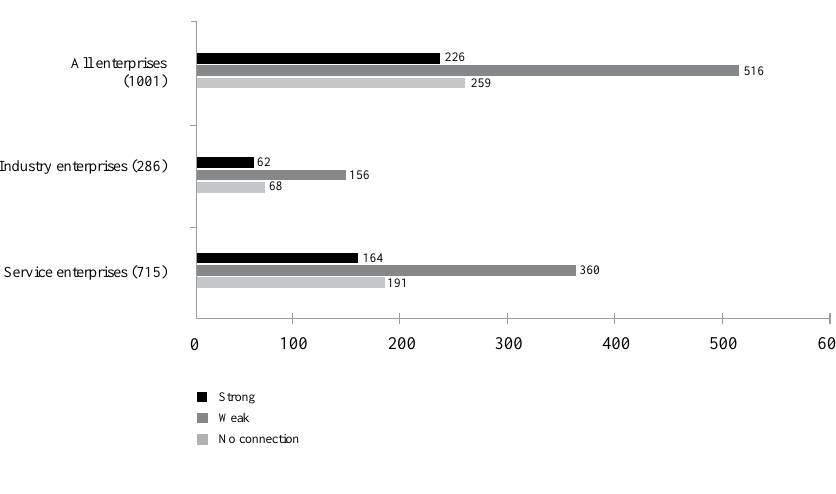
fig. 15. Connection between business sector and